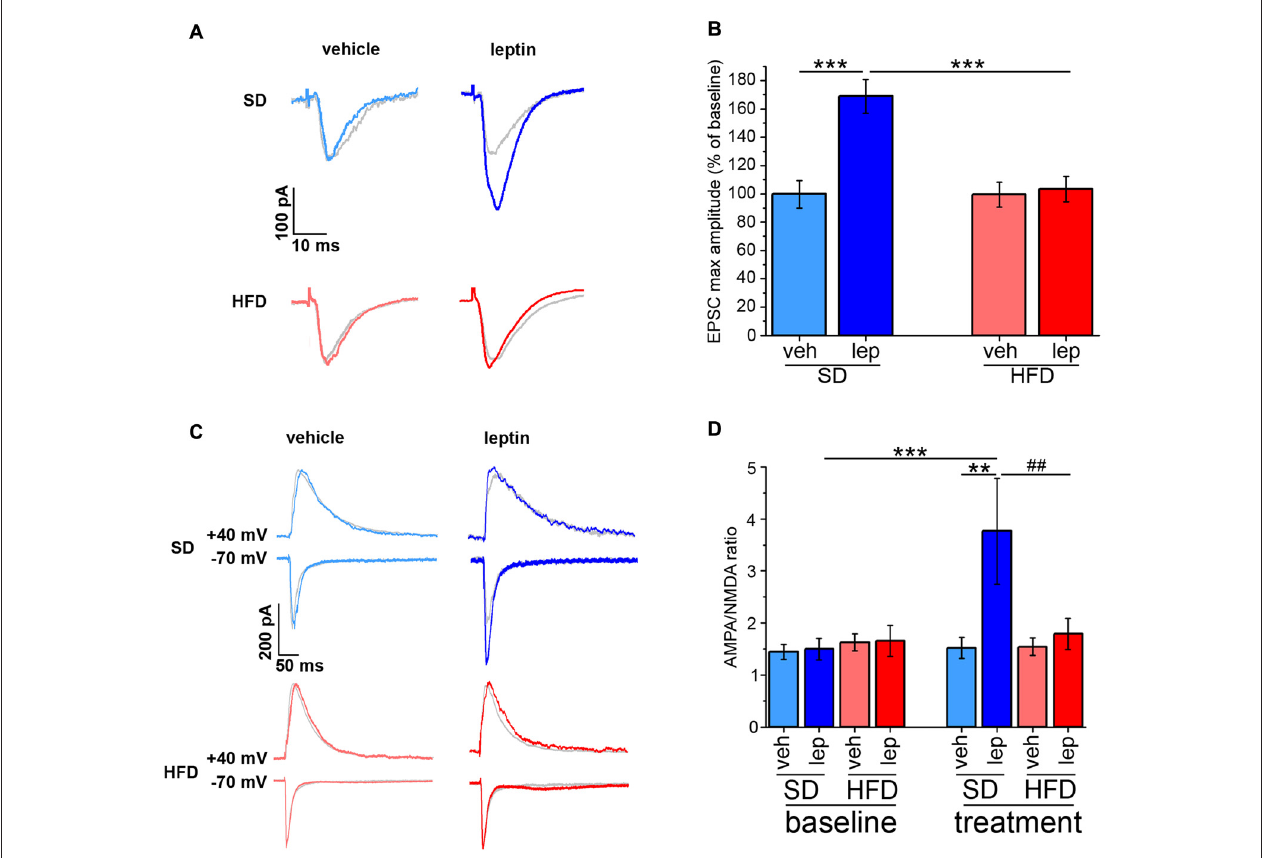
FIGURE 2 | HFD mice are resistant to potentiation of AMPA receptor-mediated evoked excitatory postsynaptic currents (EPSCs) by leptin. (A) Representative traces showing the amplitude of AMPA receptor-mediated EPSCs before and after application of either vehicle or leptin. The post-treatment response is superimposed to the baseline response of the same cell, depicted in gray. (B) Leptin induces potentiation of AMPA receptor-mediated evoked EPSCs is SD mice; this effect is completely abolished in HFD mice (SD-veh n = 11, SD-lep n = 14, HFD-veh n = 12, HFD-lep n = 16; ANOVA-2, diet × treatment interaction, p = 0.002, followed by Bonferroni post hoc test, ∗∗∗ p < 0.001). (C) Representative traces showing AMPA and NMDA receptor-mediated evoked EPSCs ( − 70 and +40 mV holding potentials, respectively) before and after application of either vehicle or leptin. Baseline responses are depicted in gray and are superimposed to the post-treatment response of the same cell. (D) AMPA/NMDA curents ratio of SD mice is enhanced by leptin, whereas HFD mice fail to display this effect (SD-veh n = 10, SD-lep n = 11, HFD-veh n = 12, HFD-lep n = 10; ANOVA-2, diet × treatment interaction, p = 0.017, followed by Bonferroni post hoc test, ## p = 0.008, ∗∗ p = 0.003, ∗∗∗ p <